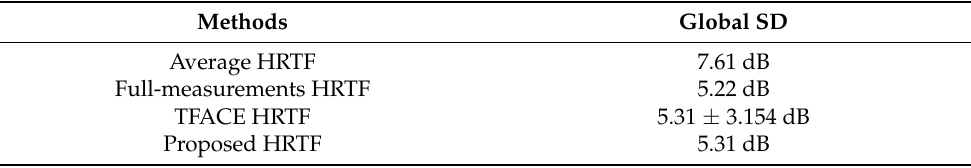
Table 2. Comparing Global SD of Different